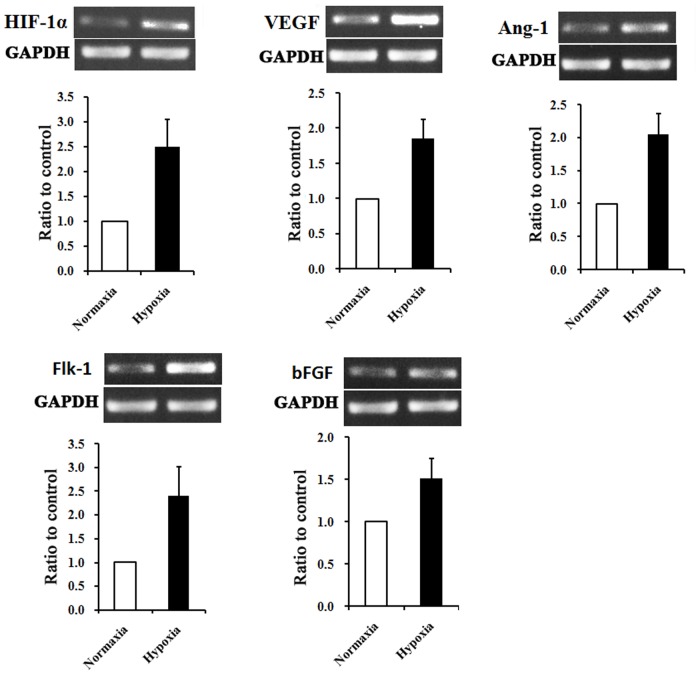
Hypoxia preconditioning upregulates angiogenesis-related factors in AMSCs.RT-PCR demonstrated that several cytokines that were related to neovascularization or vascular protection were significantly unregulated in hypixia-preconditioned AMSCs compared with normoxia ones (P<0.01 in each factor).